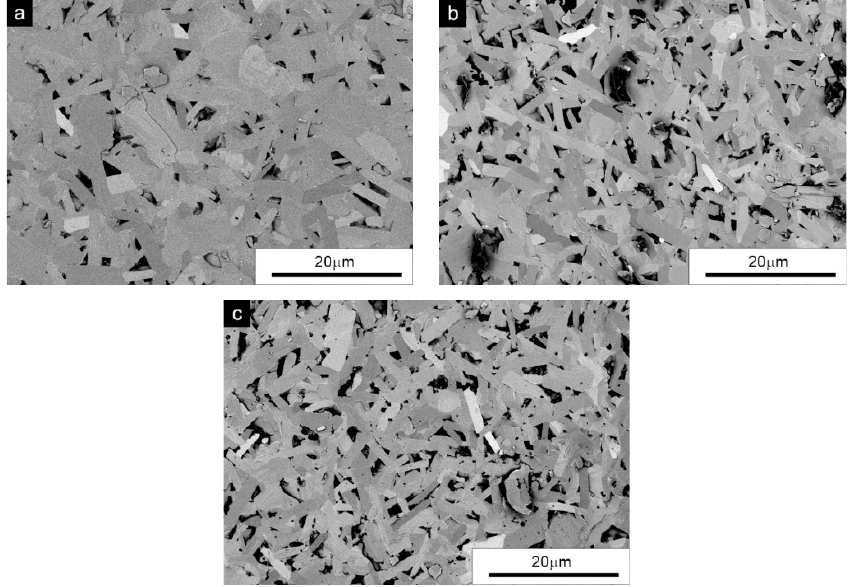
Figure 2. Microstructure of SiC sinters’ fractures for the starting powders with an α / β ratio of 0/100: